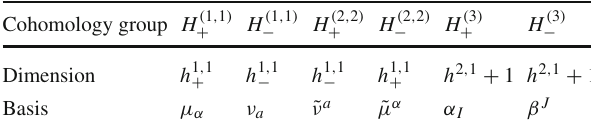
Table 1 Representation of various forms and their counting Cohomology group H